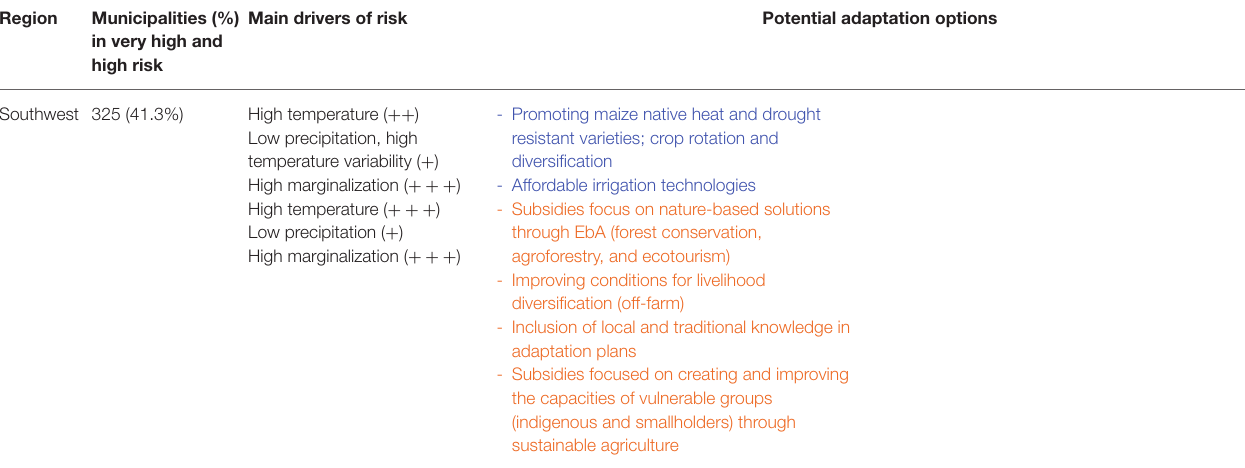
Region Municipalities (%) Main drivers of risk Potential adaptation options in very high and high risk Southwest 325